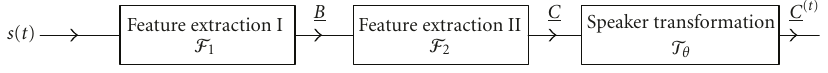
Figure 6: Steps from signal to transformed cepstral coe ffi cients.